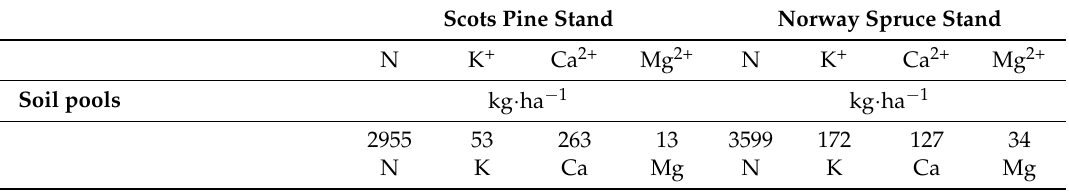
Table 7. Pools of total N and exchangeable K + , Ca 2+ , and Mg 2+ , annual rates of nutrient inputs and outputs, as well as the nutrient balance under different biomass extraction scenarios (SO, WT excl. needles, WT) of the Scots pine stand and the Norway spruce